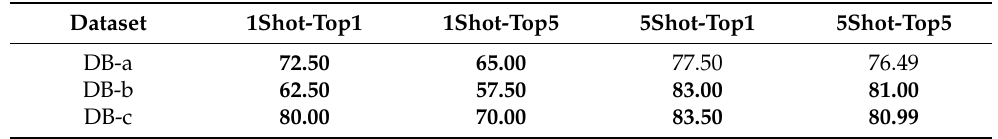
Table 3. 5-way 1-shot and 5-way 5-shot Classification top 1 and top 5 accuracy (%) for new subject on CapgMyo with MAML. The meta batch size is set to 8. The boldface numbers represent the best classification accuracies for each dataset compared with Table